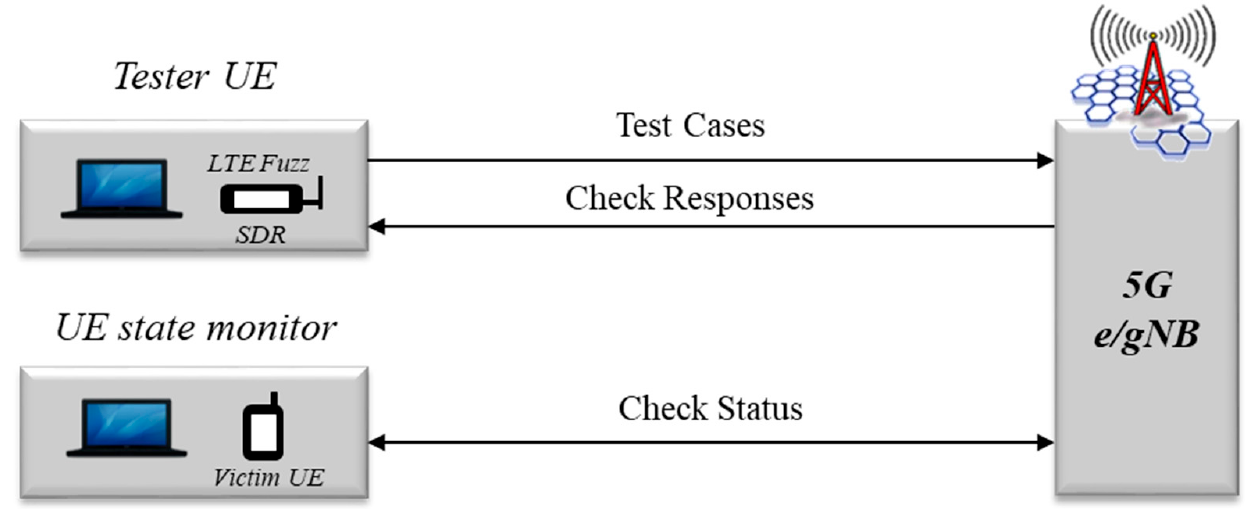
Figure 10. Testing procedure of LTE Fuzz for 5G security threat assessment.